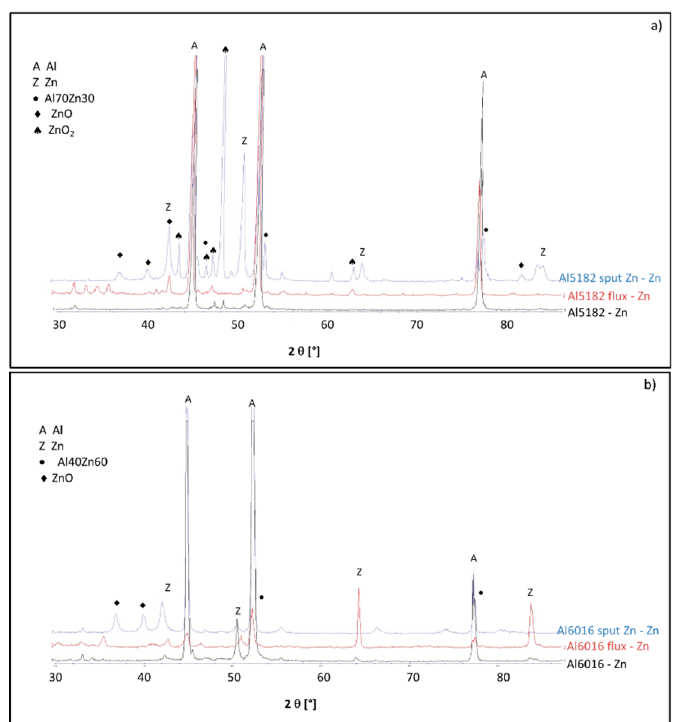
Figure 4. XRD spectra of the top surface of samples after the “spreading test”. (Zn as brazing material.): ( a ) Al 5182 substrate; ( b ) Al 6016 substrate. Coatings 2019 , 9 , x FOR PEER REVIEW